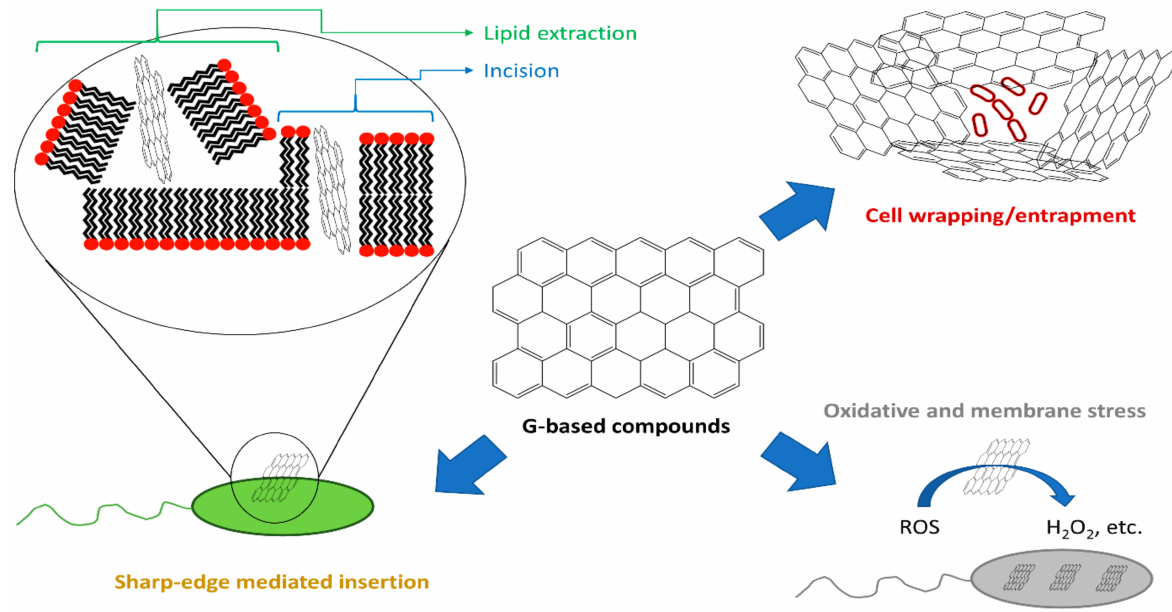
Scheme 2. Representation of the mechanisms of antibacterial activity of G and its